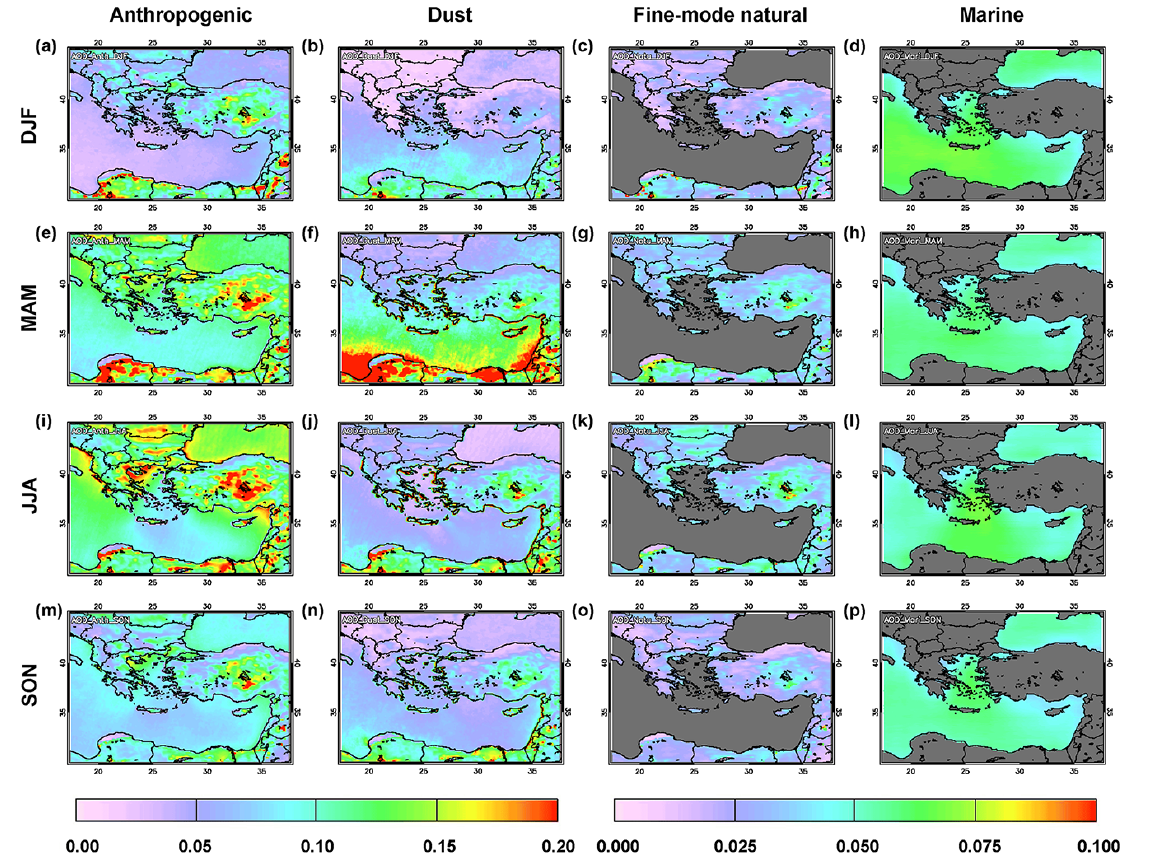
Figure 11. Seasonal (a, e, i, m) anthropogenic aerosol ( τ a ) , (b, f, j, n) dust ( τ d ) , (c, g, k, o) fine-mode natural aerosol ( τ n ) and (d, h, i, p) marine aerosol ( τ m ) patterns over the Eastern Mediterranean based on MODIS Terra observations during the period March 2000– December 2012 (March 2000–December 2007 for regions of northern Africa covered by DB data